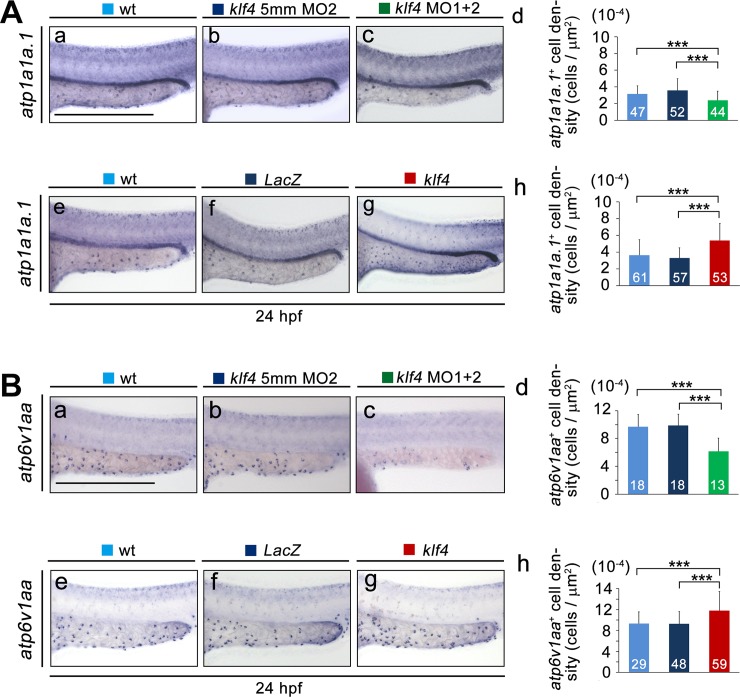
Perturbation of klf4 expression affects the densities of NaR and HR cells at 24 hpf.(A) The density of atp1a1a.1+-Na+-K+-ATPase-rich (NaR) cells was reduced in yolk extensions of embryos injected with both klf4 MO1 and MO2 (c) as compared to uninjected wild types (a) and control embryos injected with klf4 5mmMO2 (b). The density of atp1a1a.1+-NaR cells was increased in yolk extensions of embryos injected with klf4 (g) mRNA, as compared to embryos injected with the same amount of LacZ (f) mRNA, or uninjected wild type (e) embryos. Quantification of results from (a-c) and (e-g) are shown in (d) and (h), respectively. (B) The density of atp6v1aa
+- H+-ATPase-rich (HR) cells was reduced in yolk extensions of embryos injected with both klf4 MO1 and MO2 (c) as compared to uninjected wild types (a) and control embryos injected with klf4 5mmMO2 (b). The density of atp6v1aa
+-HR cells was increased in yolk extensions of embryos injected with klf4 (g) mRNA, as compared to embryos injected with the same amount of LacZ (f) mRNA, or uninjected wild-type (e) embryos. Quantification of results from (a-c) and (e-g) are shown in (d) and (h), respectively. Statistical significance was determined by Student’s t-test. ***p < 0.001. Scale bar, 300 μm. Error bars indicate standard error.